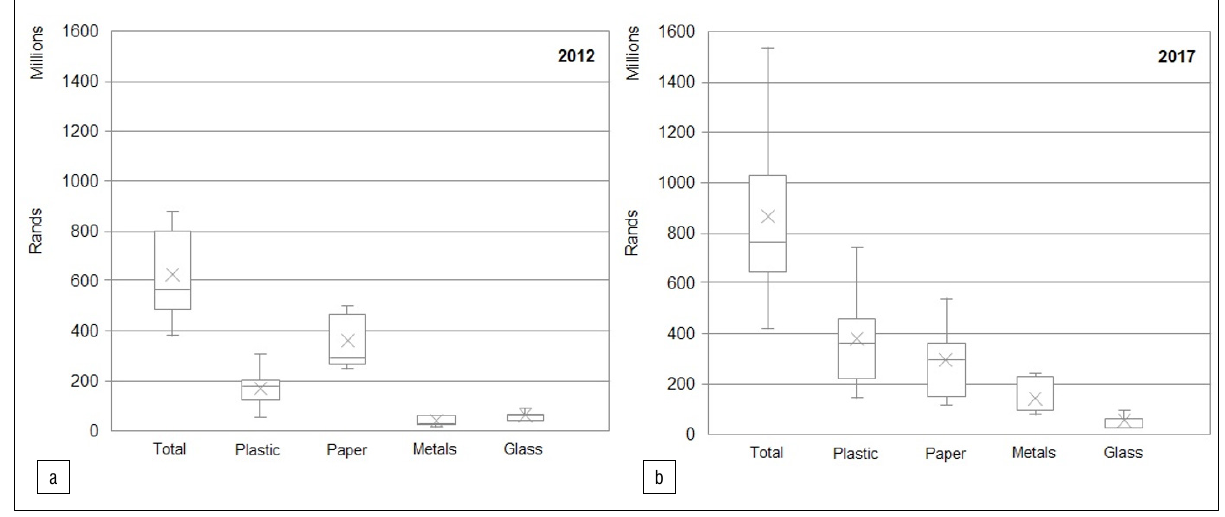
Figure 1: Estimated range (total and per recyclable stream) of money paid by business, via buy-back centres, to informal waste reclaimers in (a) 2012 and (b) 2017. Estimated payment to informal reclaimers in South Africa via buy-back centres in 2012